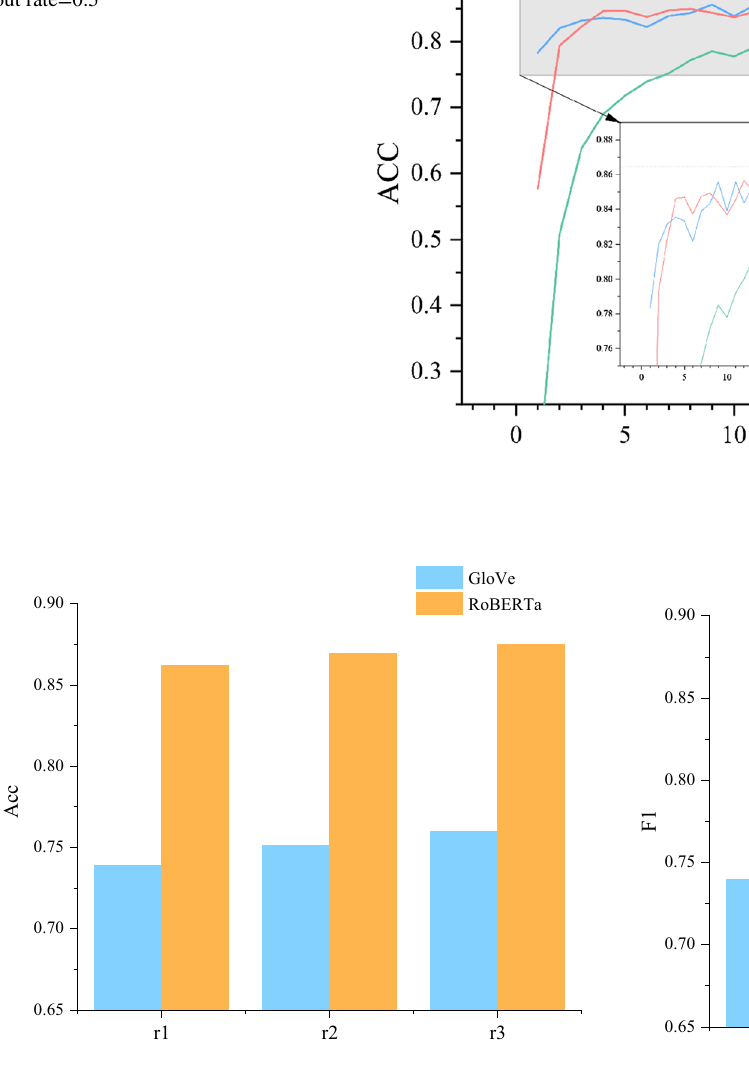
Fig. 11 Accuracy comparison of different optimizers at drop- out rate=0.5